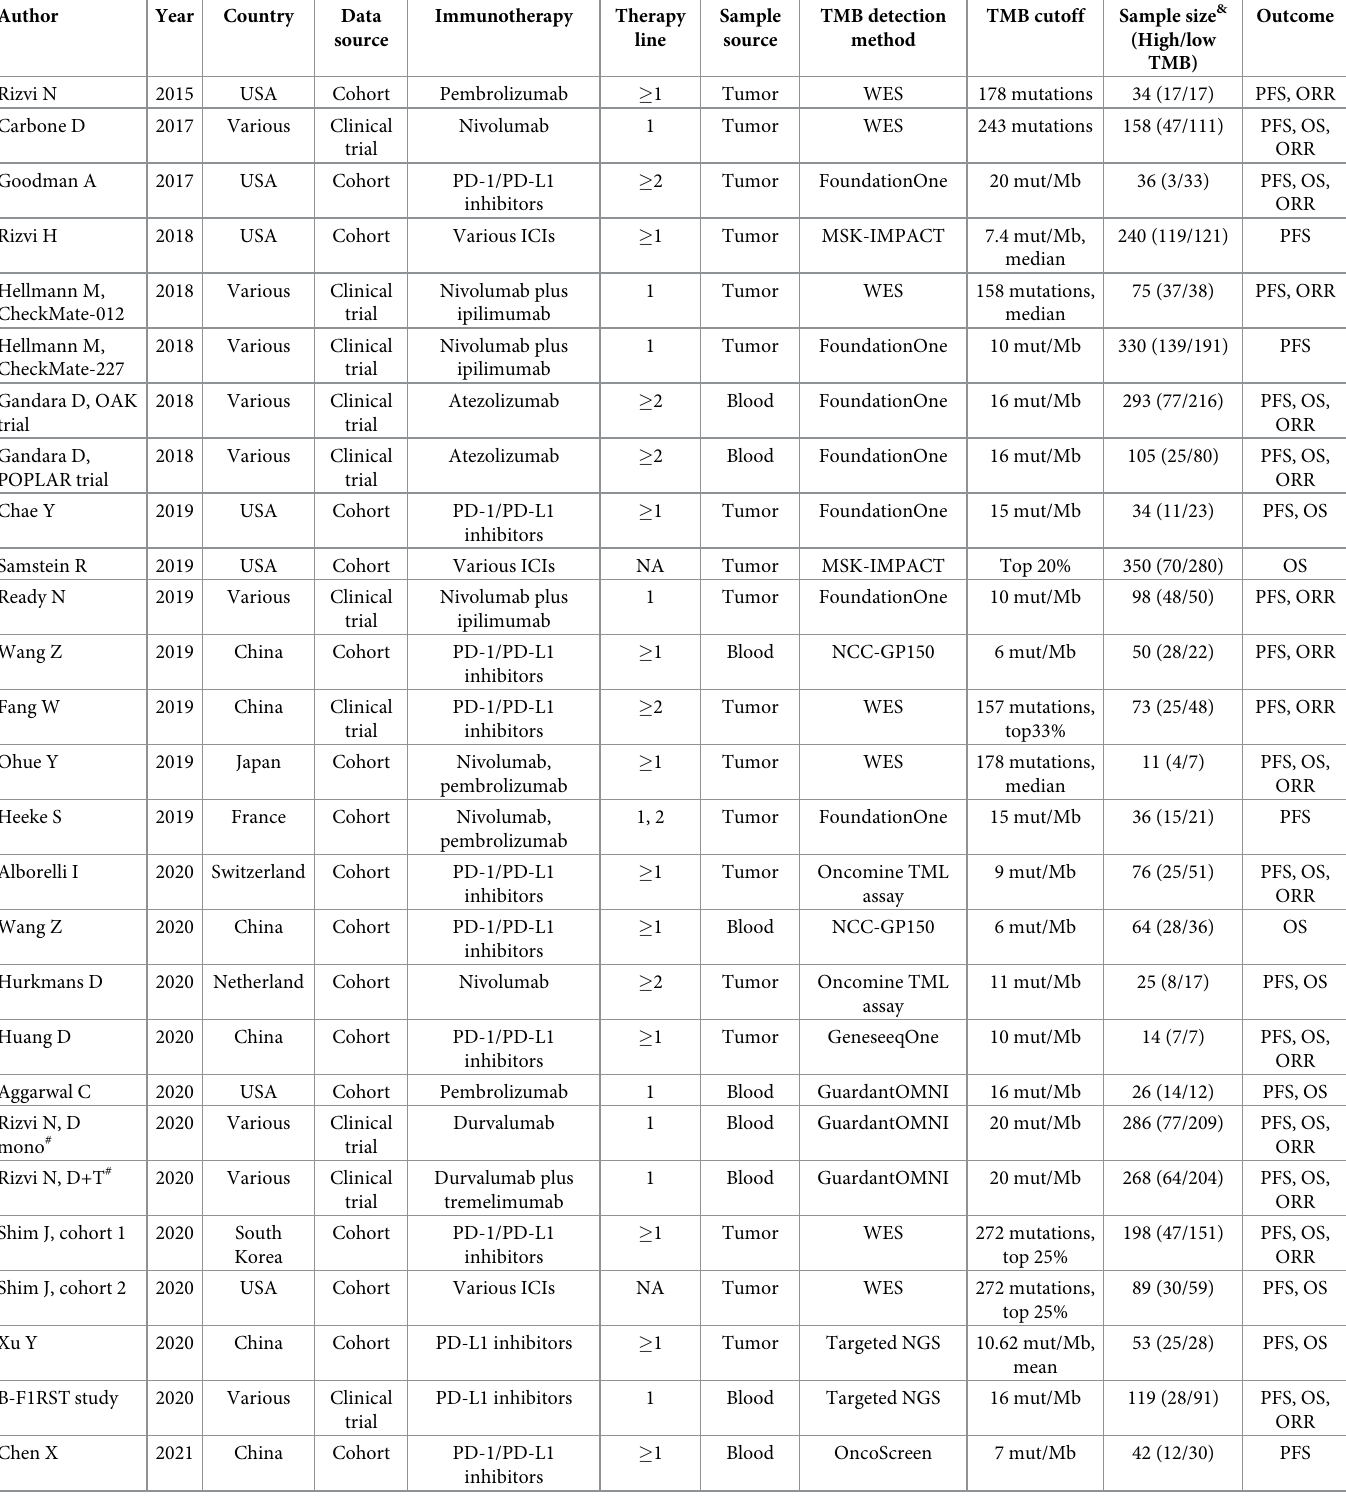
Table 1. Baseline characteristics of studies in meta-analysis comparing high TMB group with low TMB group in NSCLC patients receiving